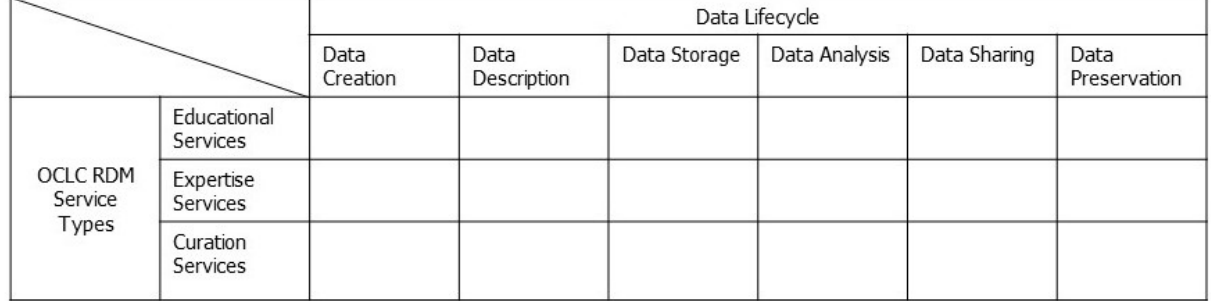
Figure 1 Conceptual framework of the study